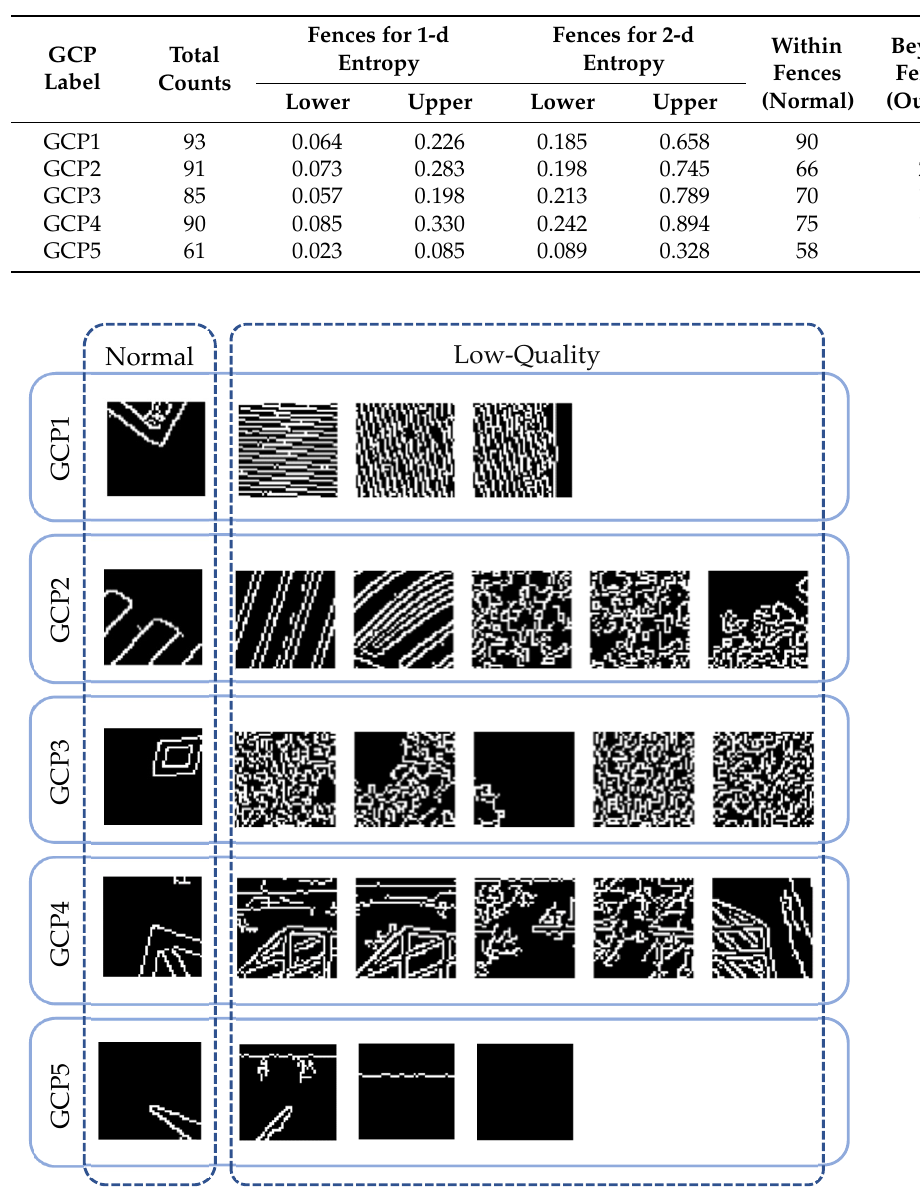
Figure 9. Edge features of normal and low-quality ROIs: up to 5 samples for each GCP are displayed. The result of fences-based low-quality ROI identification is not entirely accurate, and there may be some cases of wrong judging. Therefore, to evaluate actual accuracy, the results from the adjusted boxplot were compared with the manual classification results in Figure 6. Furthermore, the sensitivity and specificity are calculated as follows: